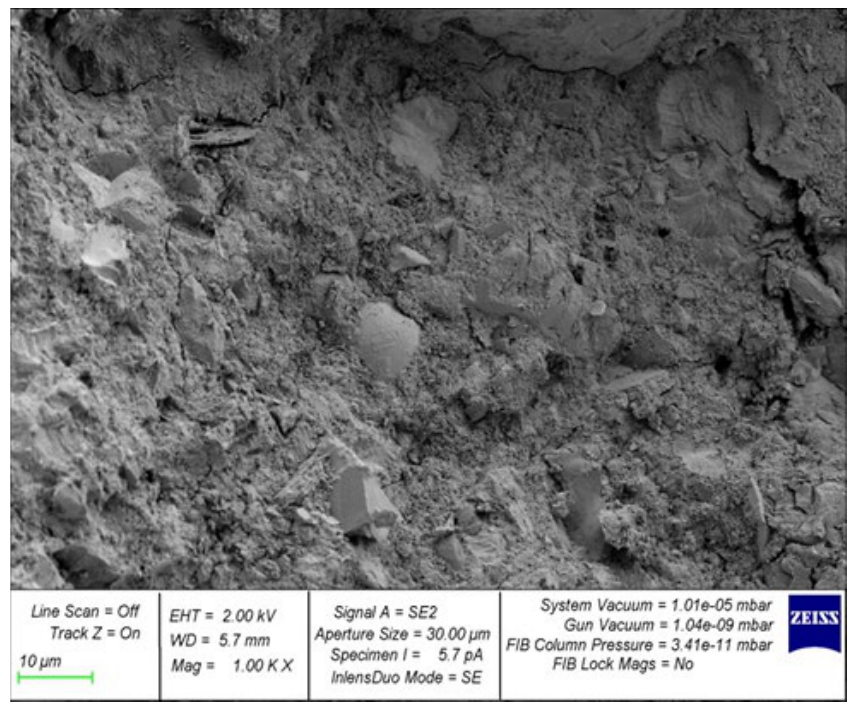
Figure 14. SEM image of the structure of the hardened cement paste of the control composition.